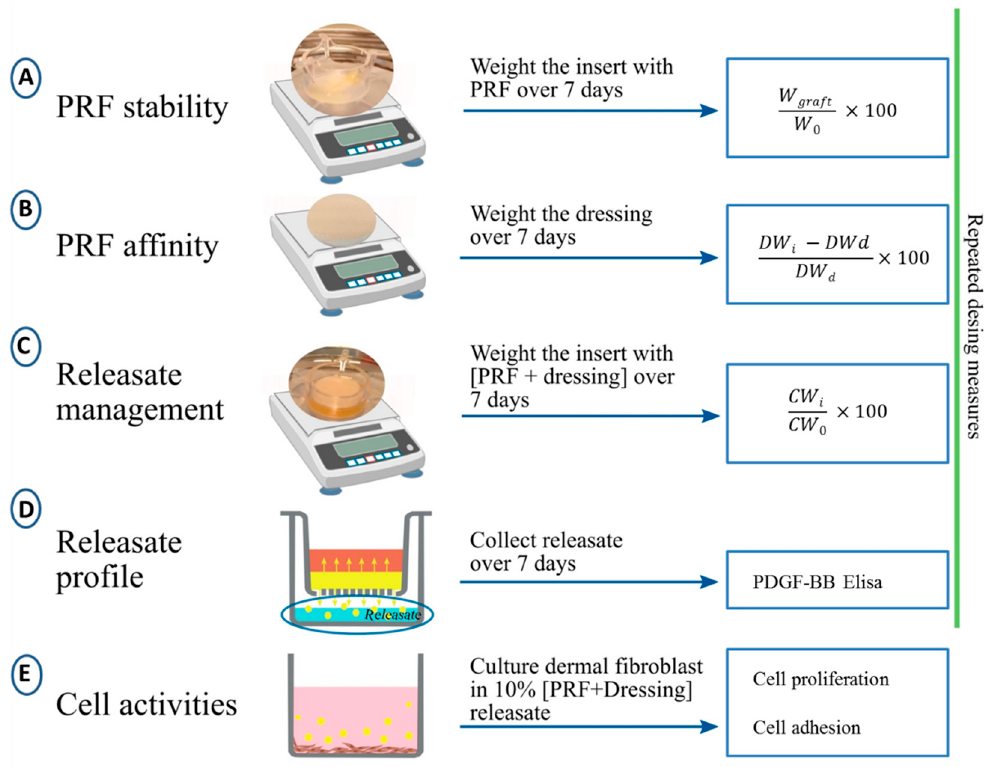
Figure 5. Experimental design. ( A )Assessment of PRF stability; Wgraft: [insert + PRF] weight at each time point; W 0 : initial [insert + PRF] weight. ( B ) Assessment of PRF affinity index; DWi: dressing weight at different time point; DWd: dressing dry weight. ( C ) Releasate management measurement; CWi: [insert + combination product] weight at each time point; CW 0 : initial [insert + combination product] weight. ( D ) Kinetics of PDGF-BB release over 7 days; orange area: dressing; yellow area: PRF; yellow dots: releasate; yellow arrows: PRF releasate distribution; blue area: simulated wound fluid. ( E ) In vitro study of PRF realasate effect in cell activities; pink: cell culture conditioned media [DMEM + 10% PRF releasate]; yellow dots: releasate; bottom: adhered dermal fibroblasts.